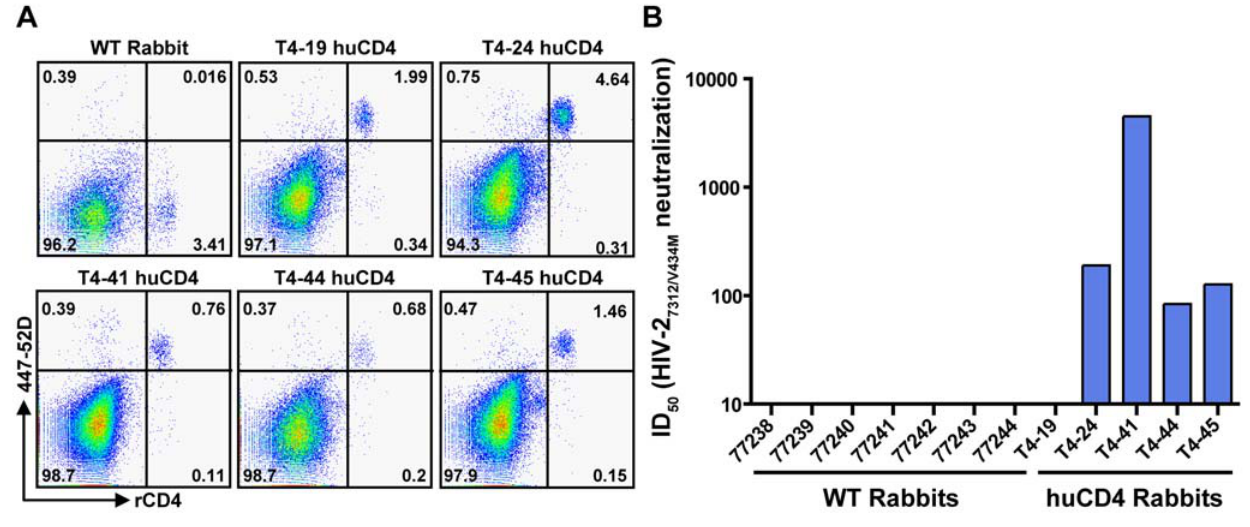
Figure 5. Characterization of huCD4 rabbit PBMCs and HIV-2 neutralization. (A) CD4 expression and YU2 gp140-F trimer binding to PBMCs from WT and huCD4 rabbits (T4-19, T4-24, T4-41, T4-44 and T4-45) was analyzed by flow cytometry. PBMCs were incubated with 20 m g/ml of the gp140-F trimers and stained with an anti-rabbit CD4 antibody (x-axis) followed by detection of trimer binding with the mAb 447-52D (y-axis) (see supplemental Fig S5 for gating strategy). rCD4 + /Env 2 cells are located in the lower right quadrant while rCD4 + /Env + cells are located in the upper right quadrant. The percentage of cells detected in each quadrant is indicated. (B) ID 50 HIV-2 7312/V434M neutralization in the presence of 9 nM sCD4 by serum samples from WT and huCD4 rabbits (blue) after 3 immunizations with the gp140-F